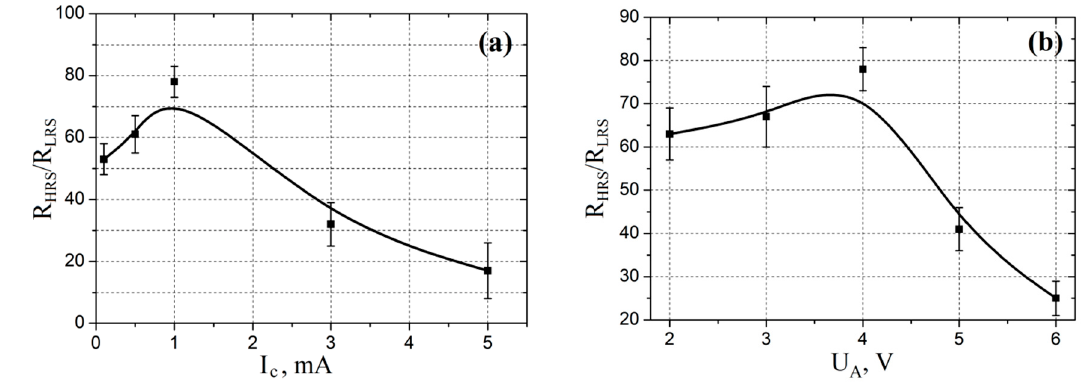
Figure 13. Experimental investigations of dependences of R HRS / R LRS ratio on ( a ) current compliance and ( b ) sweep voltage.